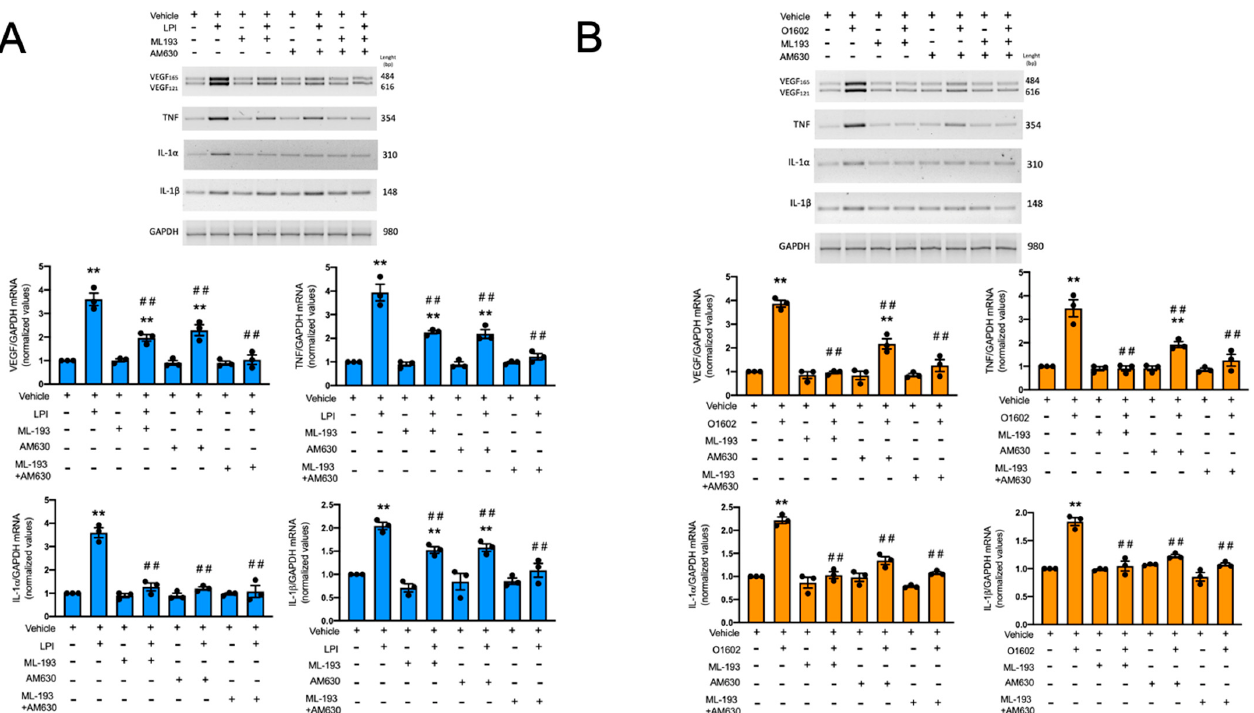
Figure 7. GPR55 and CB2 receptors mediate LPI and O1602-induced cytokine mRNA accumulation in BMMCs. Panel ( A ): BMMCs were treated for three hours with LPI (1 µM) in the presence of vehicle, ML193 (100 nM), or AM630 (100 nM). Total RNA extraction, cDNA synthesis, and RT-PCR were performed as described in the Materials and Methods section. A representative image of a 2% agarose gel with the corresponding amplification fragments is shown in the upper part of the figure, whereas, in the lower part, the quantification of at least three experiments is shown. Panel ( B ): cells were treated with O1602 (100 nM) and the respective GPR55 or CB2 receptor antagonists, as in panel A. In both panels, the effect of each antagonist alone and the combination of both is also shown. Data are presented as the mean ± SEM of at least three independent experiments. ** p < 0.01 vs. vehicle; ## p < 0.01 vs. LPI or O1602. Blue and orange bars show data obtained stimulating the cells with LPI or with the GPR55 agonist O1602,